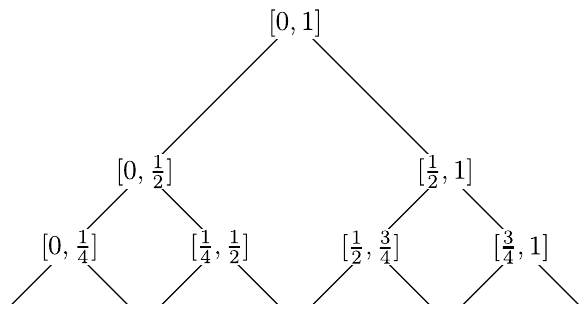
Figure 18 . The in(cid:12)nite tree T of standard dyadic intervals. The two children of every vertex represent the two intervals obtained by dividing the interval corresponding to that vertex in two